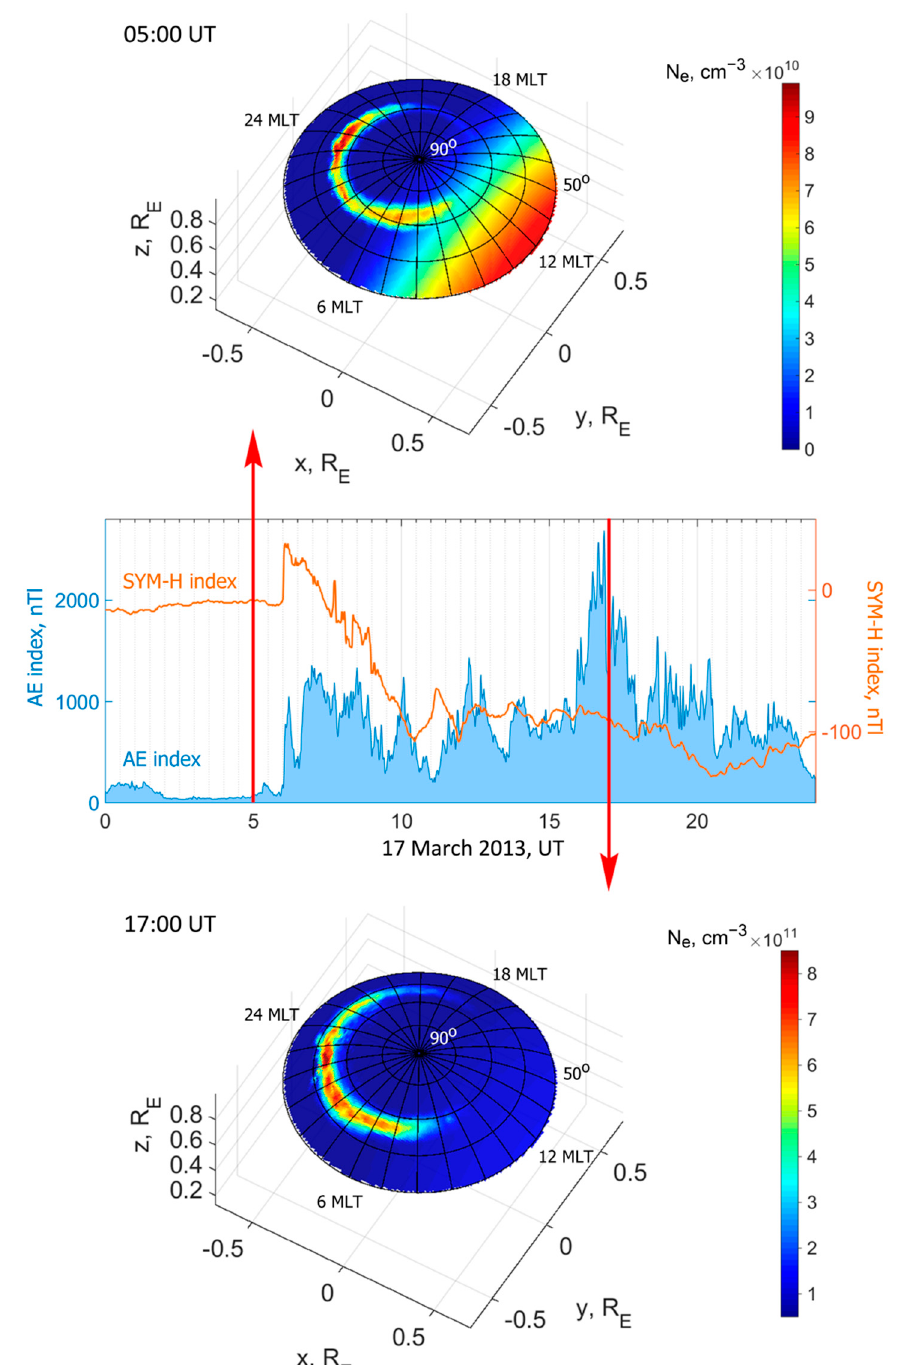
Figure 5. Geomagnetic SYM-H and AE indices variations and E layer maximum electron density spatial distribution maps for two moments (red arrows): during quiet geomagnetic conditions—5:00 UT (upper map) and main phase of the storm—17:00 UT (lower map) on 17 March 2013. Note, the colorbar scale differs by an order of magnitude.